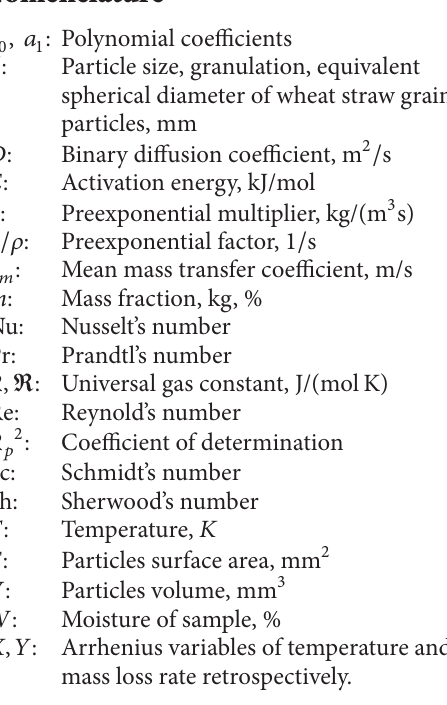
different. Statistical tests in particular regions show high significance to the law that is set by hypothesis